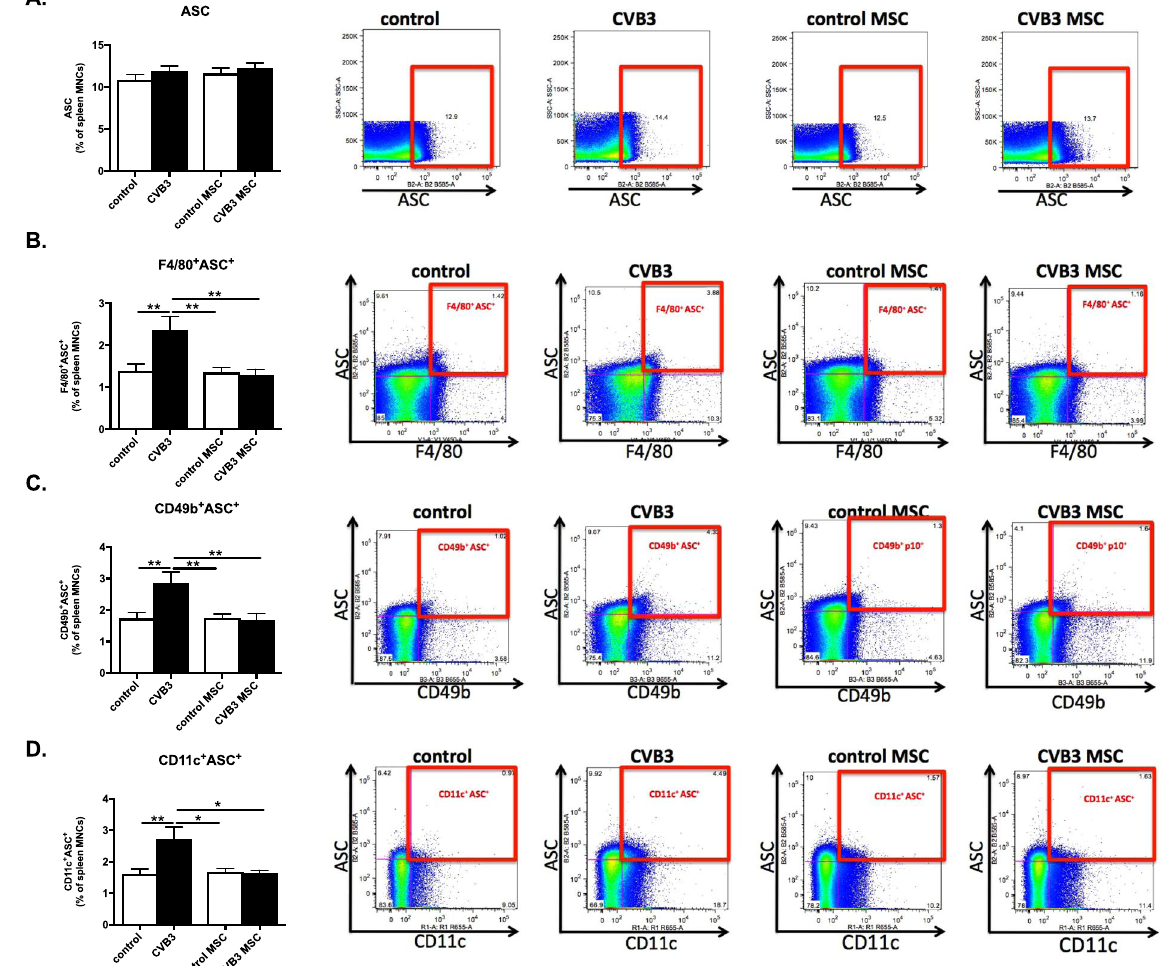
Figure 4. Mesenchymal stromal cells inhibit Coxsackievirus B3-induced ASC activation in macrophages, natural killer cells, and dendritic cells. ( A ) Bar graphs represent the mean ± SEM of ASC-positive splenocytes in control mice (open bar) and CVB3-infected mice (closed bar) injected with PBS or MSC, expressed as the percentage of total MNCs, with n = 8–9/group. The right panel shows dot plots of ASC positive splenocytes of control, CVB3, control MSC, and CVB3 MSC mice, as indicated. ( B ) Bar graphs represent the mean ± SEM of F4/80 + /ASC + in control mice (open bar) and CVB3-infected mice (closed bar) injected with PBS or MSC, expressed as the percentage of total MNCs, with n = 8–9/group and ** p < 0.01. The right panel shows dot plots of F4/80 + /ASC + - positive splenocytes of control, CVB3, control MSC, and CVB3 MSC mice, as indicated. ( C ) Bar graphs represent the mean ± SEM of CD49b + /ASC + in control mice (open bar) and CVB3-infected mice (closed bar) injected with PBS or MSC, expressed as the percentage of total MNCs, with n = 8–9/group and ** p < 0.01. The right panel shows dot plots of CD49b + /ASC + -positive splenocytes of control, CVB3, control MSC, and CVB3 MSC mice, as indicated. ( D ) Bar graphs represent the mean ± SEM of CD11c + /ASC + in control mice (open bar) and CVB3-infected mice (closed bar) injected with PBS or MSC, expressed as the percentage of total MNCs, with n = 8–9/group and ** p < 0.01. The right panel shows dot plots of CD11c + / ASC + -positive splenocytes of control, CVB3, control MSC, and CVB3 MSC mice, as